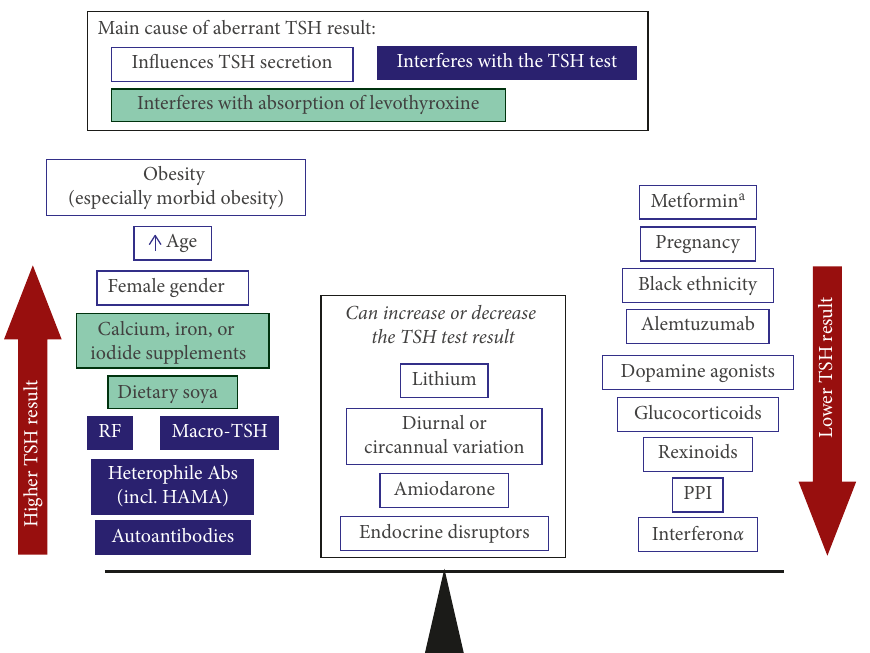
Figure 1: Overview of common factors that can produce an aberrant TSH test. a Metformin reduces serum TSH in people with overt or subclinical hypothyroidism and in euthyroid individuals with high normal baseline TSH levels (see refs [31] and [32]; see text for other references). HAMA: human anti-mouse antibody; RF: rheumatoid factor; TSH: